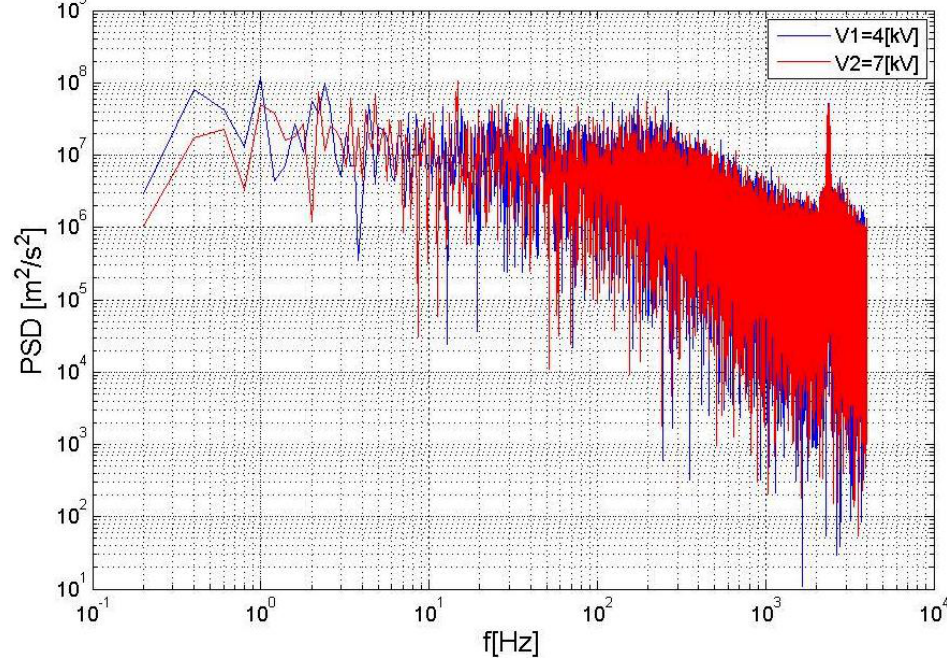
Figure 21. PSD analysis comparing applied voltages at Re = 200,000 and α = 16 ◦ , and actuation frequency f =